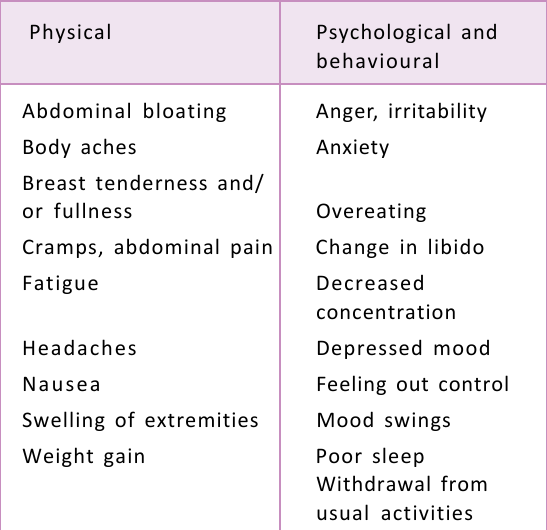
Table 1. Symptoms associated with premenstrual syndrome and premenstrual dysphoric disorder (3,